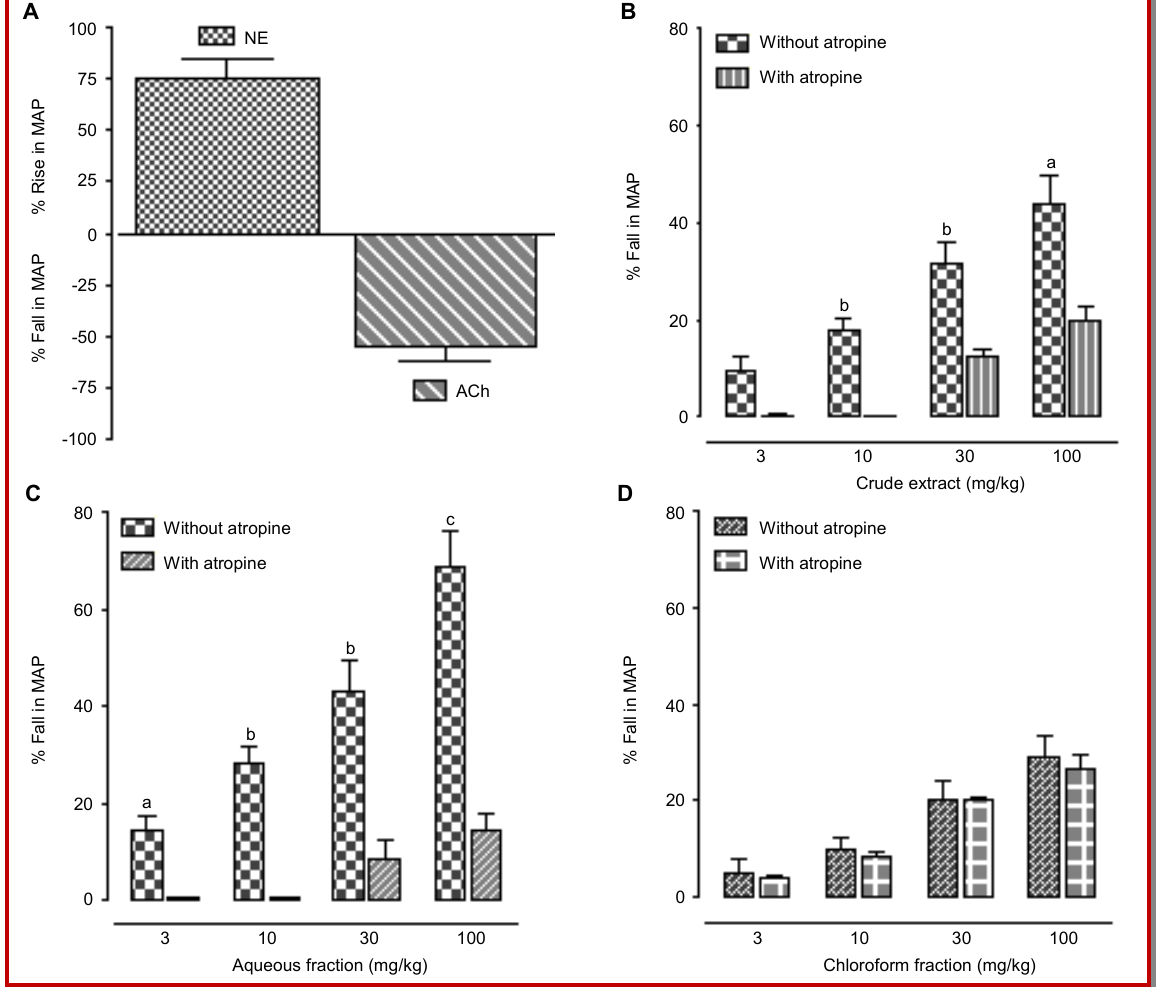
Figure 1: Effect of (A) norepinephrine (NE) and acetylcholine (ACh) on mean arterial pressure (MAP) in normotensive anesthe- tized rats. B, C and D show effect of the crude extract of M. longifolia , its aqueous and chloroform fractions, respectively, on MAP. Values shown are mean + SEM (n = 5). a p<0.01, b p<0.001, c p<0.0001; compared with values obtained in the presence of